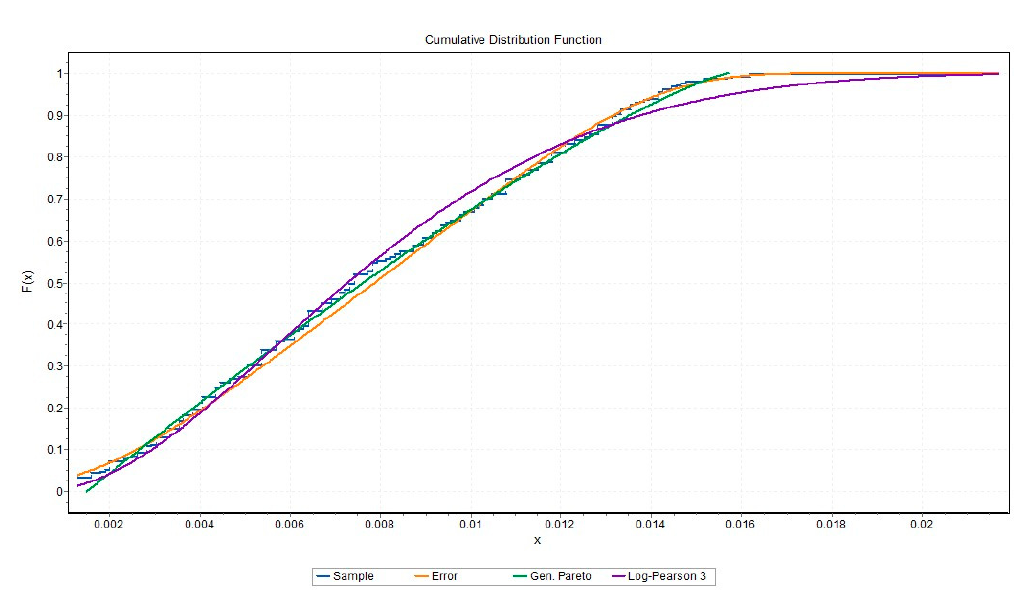
(cid:3031) (cid:3116) for d 0